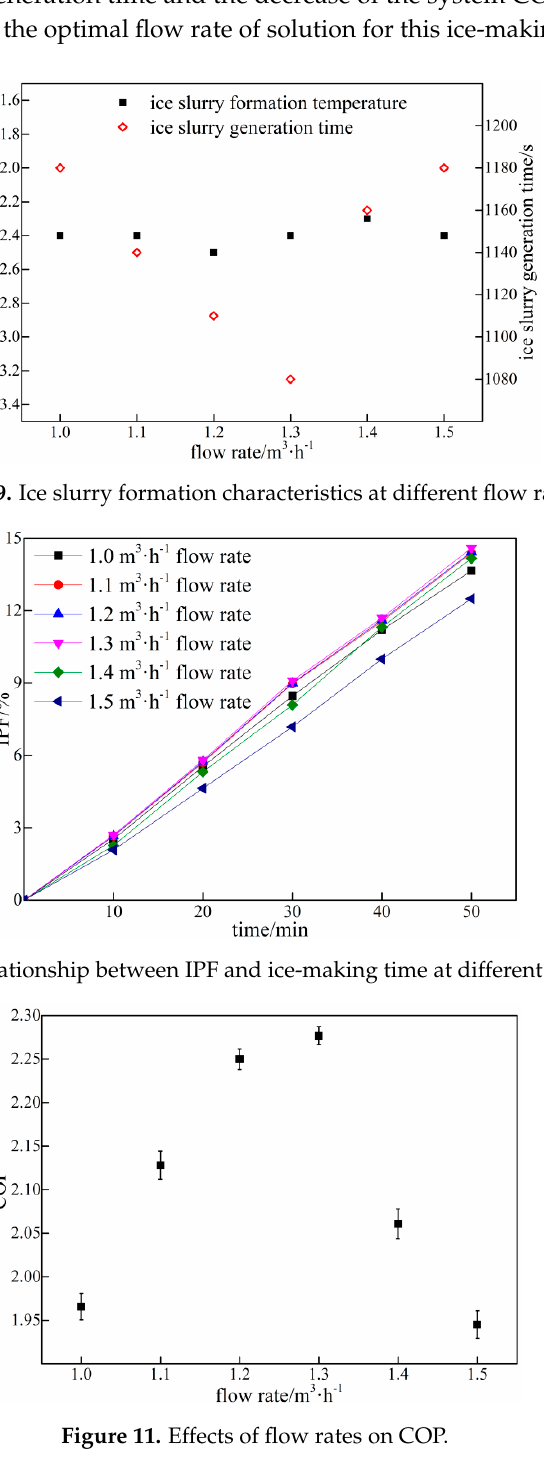
Figure 8. Effects of initial NaCl concentration on coefficient of performance (COP).